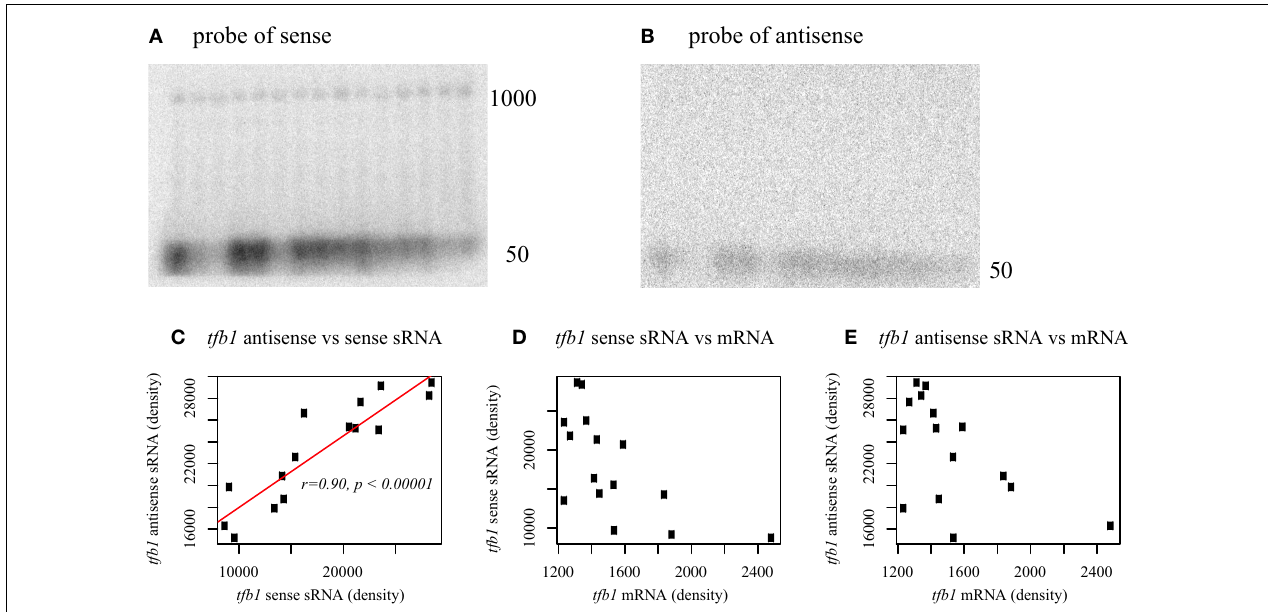
a time series for all five respiratory conditions at T = (2.5, 4.5, 7.5h) with indicated terminal electron acceptor. Sense and antisense sRNA transcript abundance, inferred from band density, is positively correlated across growth conditions (C) , while no significant correlation is found between full length tfb1 mRNA and either sRNA population (D,E) . Full length tfb1 transcripts [1000nt] remain nearly constant under all conditions tested (A) . Band density established using imagej